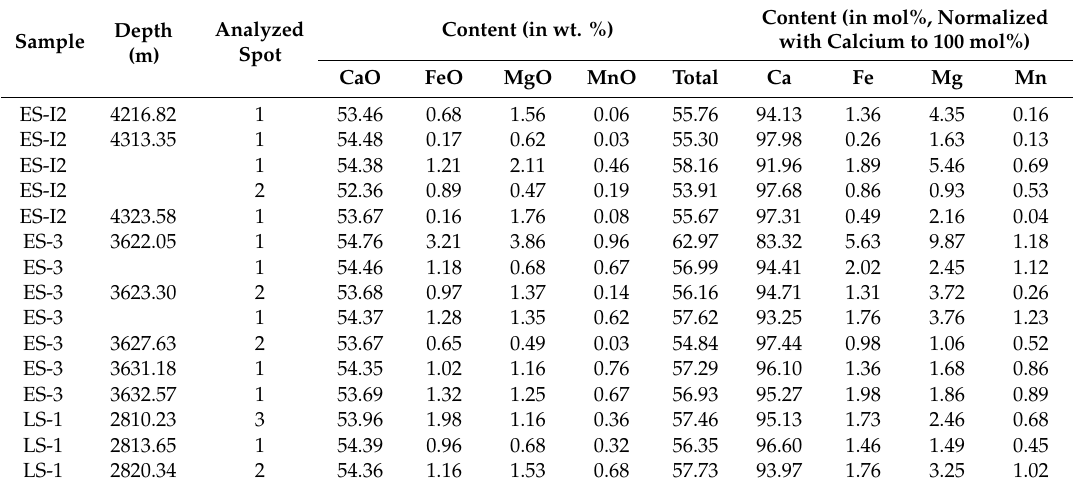
Table 1. Element (Ca, Fe, Mg and Mn) content of carbonate cements in the Lulehe sandstones. Depth Sample